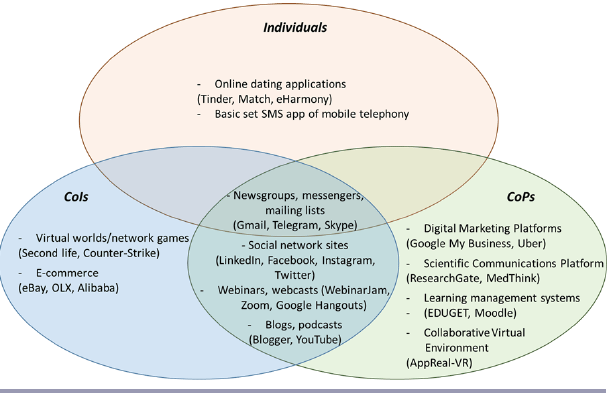
Fig. 10 . Overview of the main types of activities realized via virtual meeting places for individuals, communities of interest (CoIs), and communities of practice